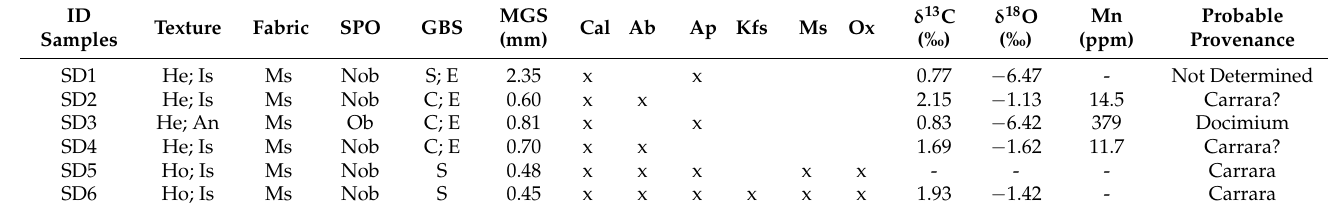
Table 2. Main mineralogical and petrographic features, carbon–oxygen isotopic data and the most